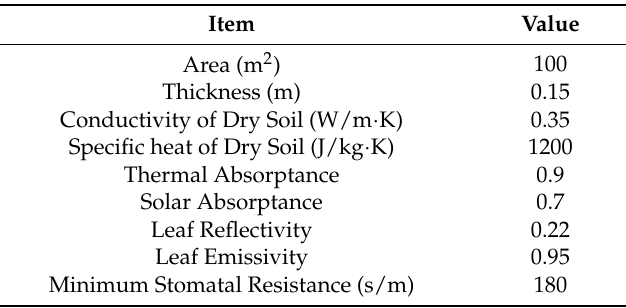
Table 9. Specification of the green roof.